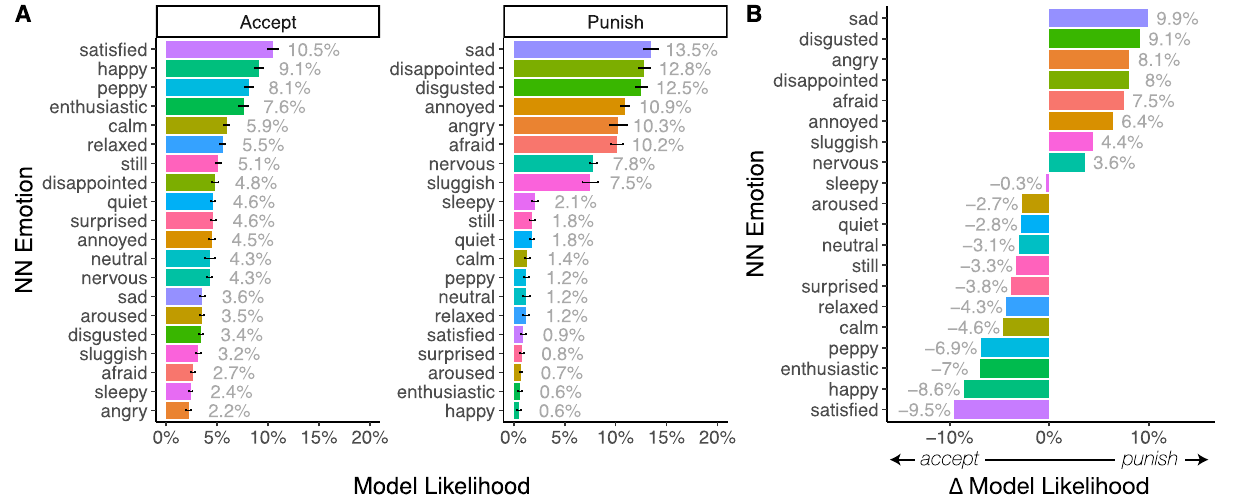
Fig. 4 Neural network emotion classi fi cations. A Classi fi cations by decisions to accept and punish. The neural network model trained on the emotion classi fi cation data is applied to the unlabeled emotion ratings from the Ultimatum Game. Each data point is assigned a probability of each emotion class and model likelihoods are averaged within participant ( N = 715) and then across choice. Bars represent mean values while error bars re fl ect 95% CIs. B Difference in probability of choice given an emotion. Model likelihoods are averaged within participants, then across choices to reveal which emotions are more likely to be associated with decisions to accept and punish. For example, the emotion sad is more speci fi c to decisions to punish than accept, whereas the emotion sleepy is equally associated with both